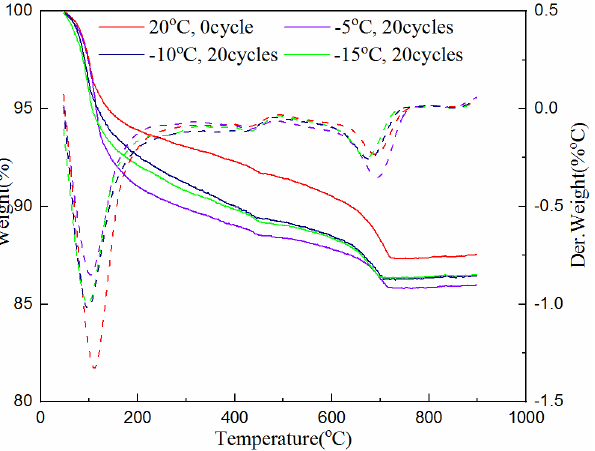
Figure 5. Hydration product of samples at different freezing temperatures after 7-day curing.